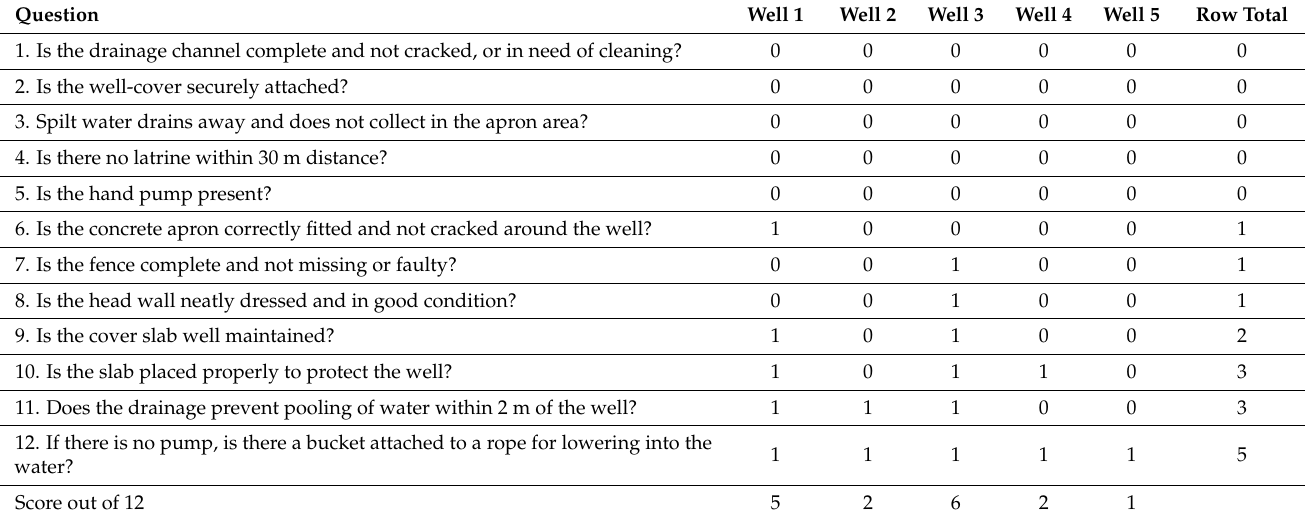
Table 2. Questions used to assess the condition of wells in Brookfields and Wilberforce in Freetown Sierra Leone in May 2021 (1 is a positive finding, 0 is